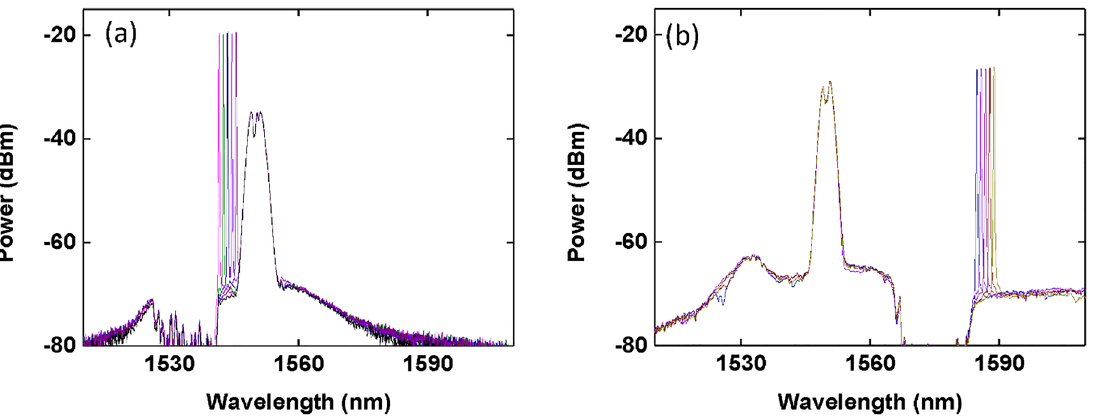
Figure6: FWMspectraatasignalwavelengthof(a)1540 – 1545nmusingtheCMBGsasthatusedinFigure4aandbsignalwavelengthof1583 – 1589 nm using the CMBGs as that used in Figure 5a. No idlers are observed in either case due to poor phase matching.